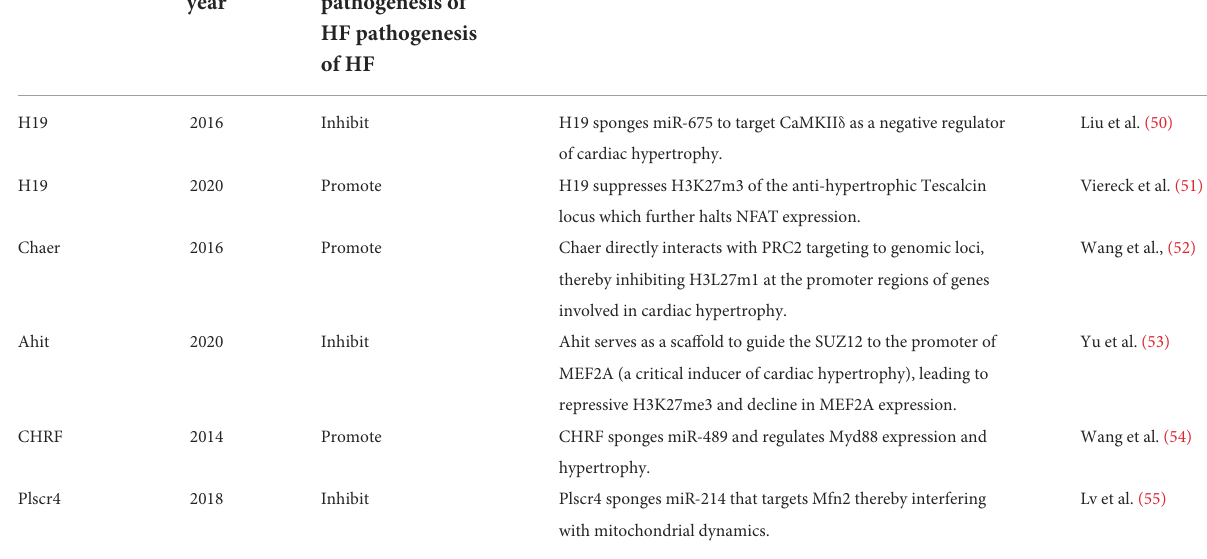
TABLE 2 lncRNAs regulating cardiac hypertrophy.